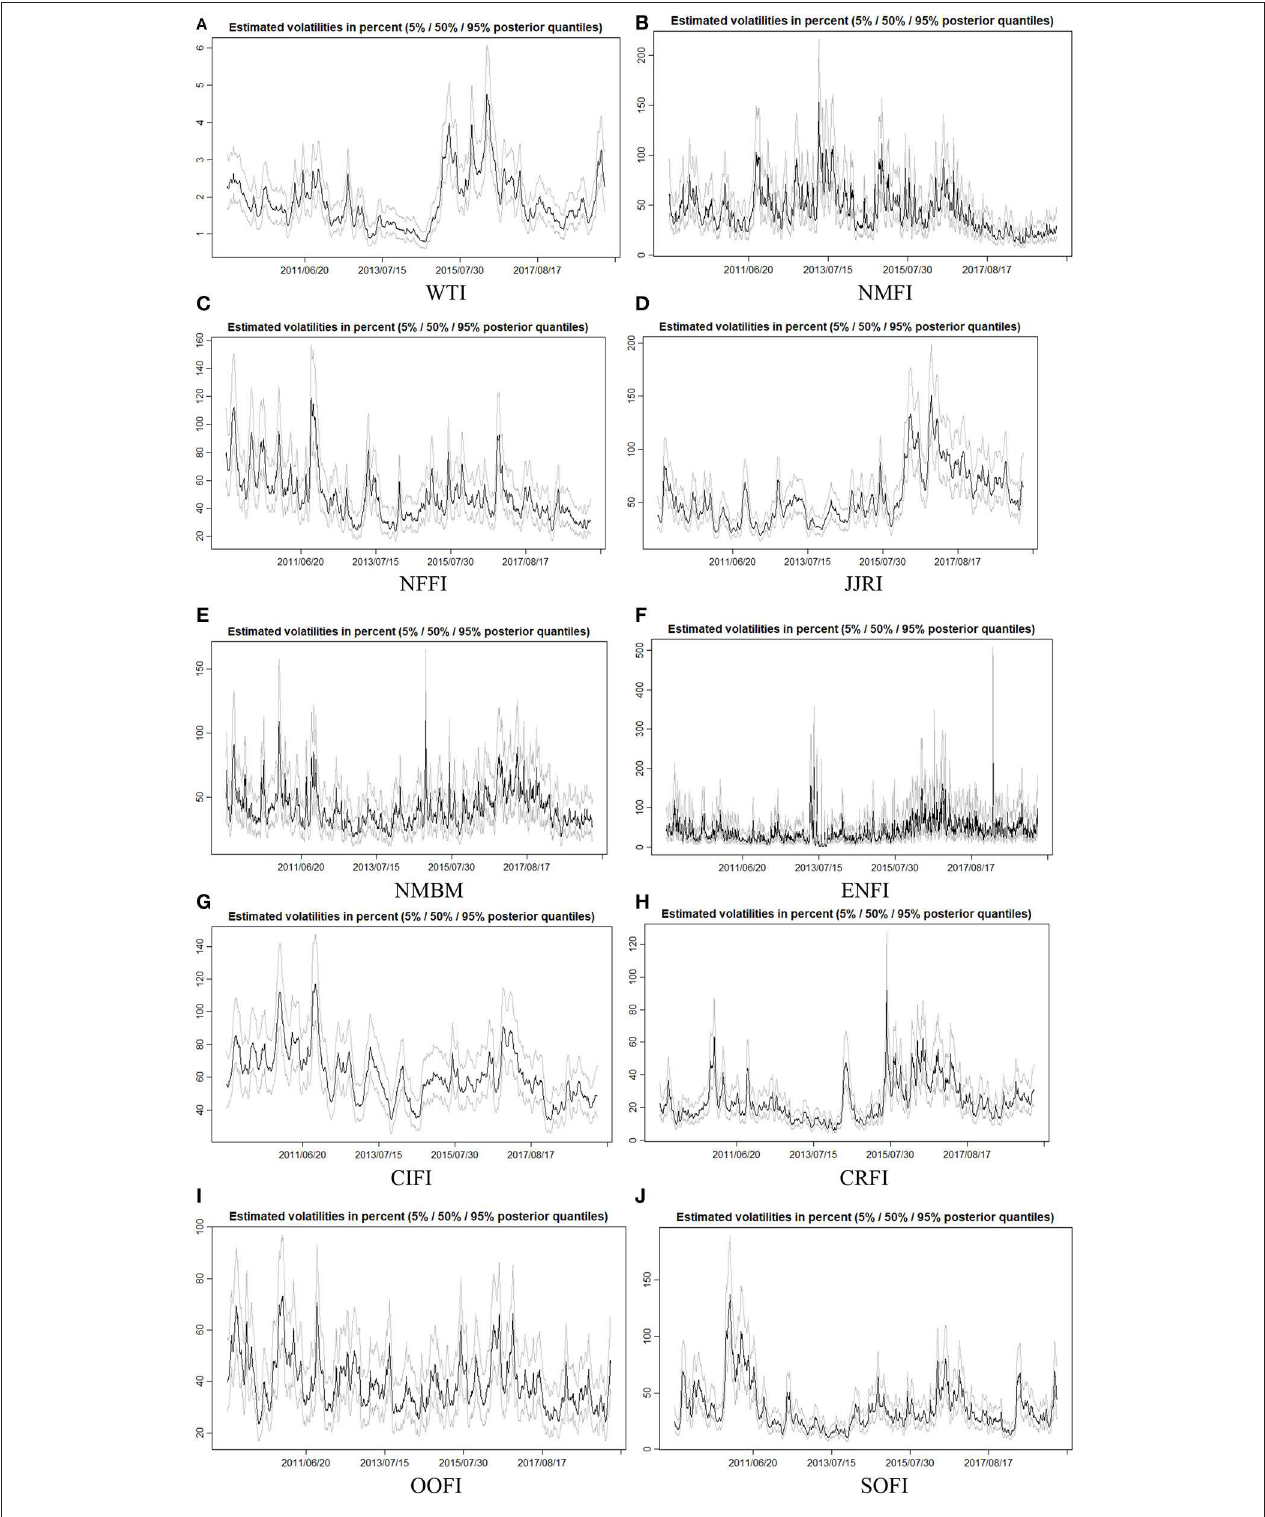
FIGURE 2 | The plots of estimated posterior stochastic volatility levels. (A) WTI, (B) NMFI, (C) NFFI, (D) JJRI, (E) NMBM, (F) ENFI, (G) CIFI, (H) CRFI, (I) OOFI, and (J) SOFI.